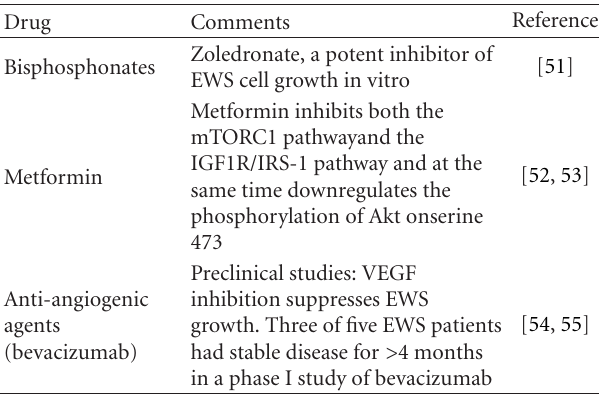
Table 5: Biologic agents with potential synergy against Ewing’s sarcoma (EWS).